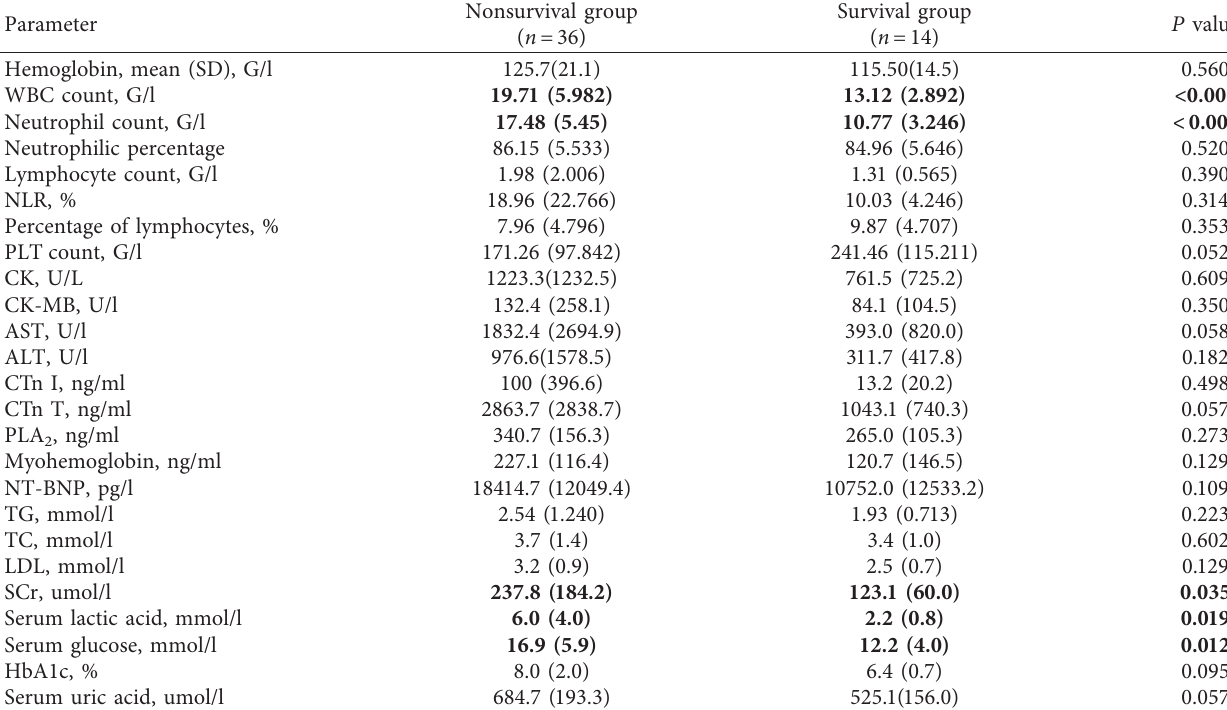
Table 3: Laboratory data of patients with ventricular septal